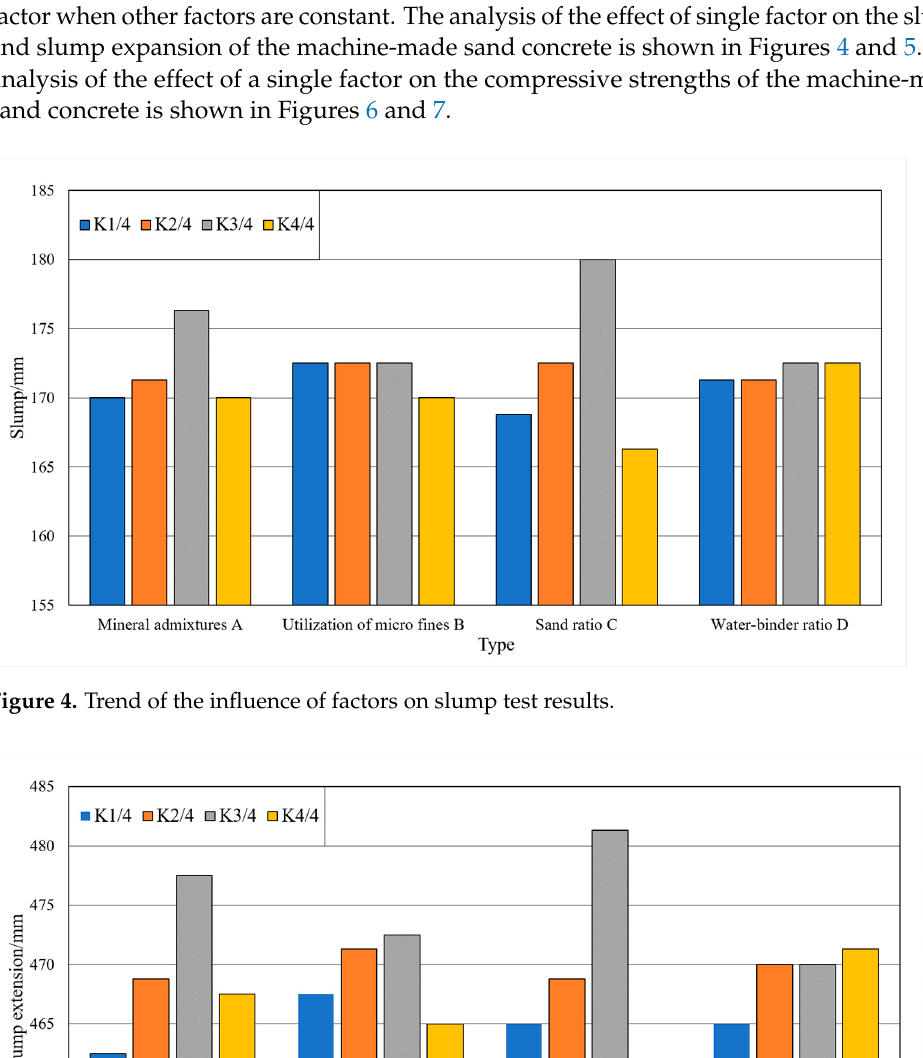
Figure 6. Trend of the influence of factors on the results of 7-day compressive strength test.